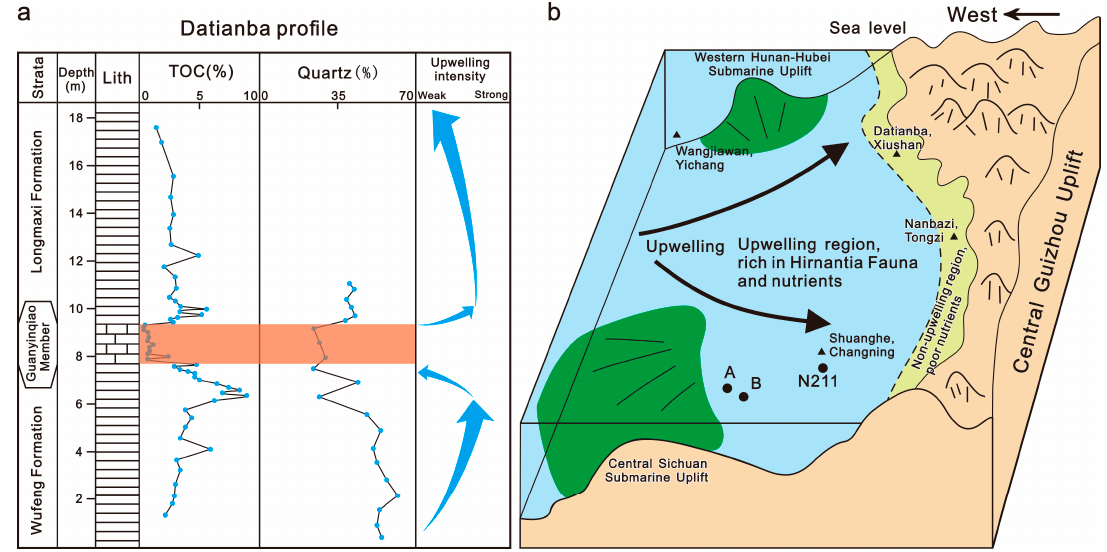
Fig ure 8 . Different developments of upwelling in the Upper Yangtze region during the 437 Figure 8. Di ff erent developments of upwelling in the Upper Yangtze region during the sedimentary sedimentary period of the Guanyinqiao Member (data for the Datianba profile are based on the 438 period of the Guanyinqiao Member. ( a ) Stratigraphic profile of the Wufeng and Longmaxi Formations of results of Liu [39] ). 439 Datianba (data for the Datianba profile are based on the results of Liu [38]); ( b ) Di ff erent developmented of upwelling in the Upper Yangtze